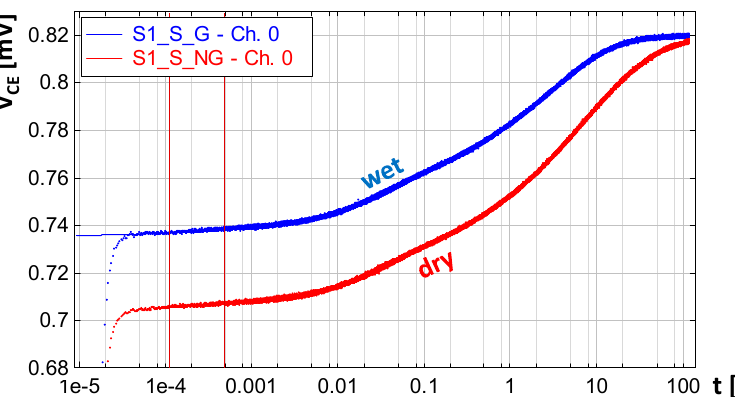
Figure 13. Measured transient of the V CE saturation voltage of an IGBT on dry and wet cold plates.